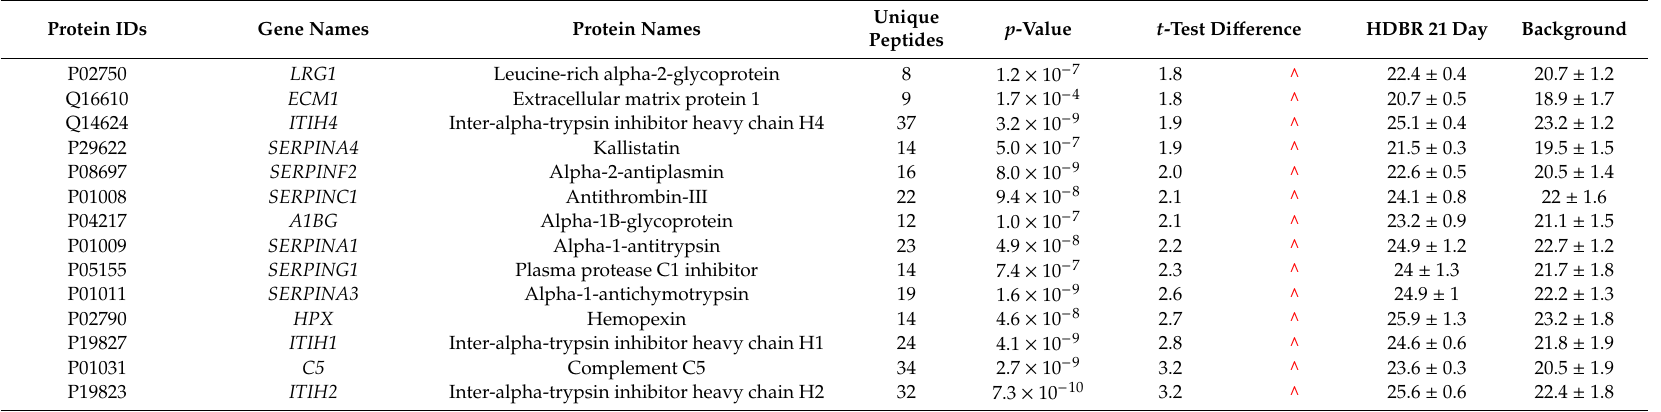
Table 1. The list of proteins significantly changed ( p < 0.01) on the 21st day of the head-down bed rest (HDBR) ground-based experiment with respect to their background levels (the day before the experiment). Proteins were identified by pair-wise comparison (Welch’s t -test). Red/blue symbol—the increase/decrease of the protein level with respect to the background.